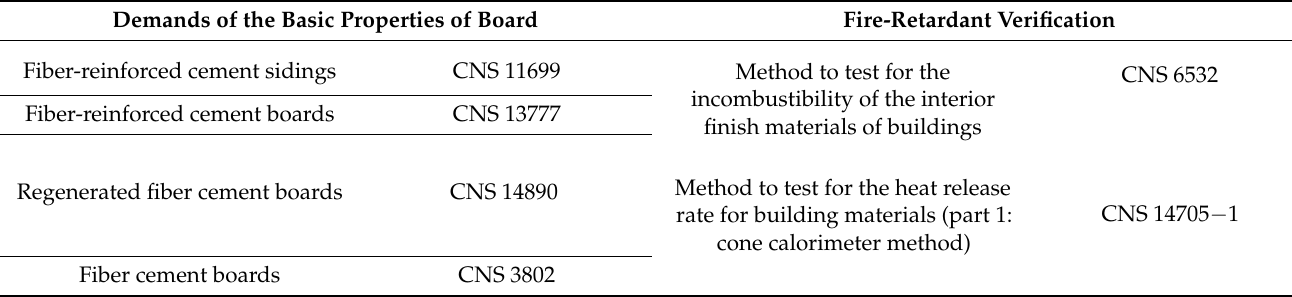
Table 3. Related standards of building material